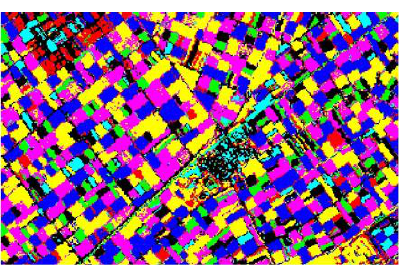
Figure 3. Classified image generated by SVM, where C=10 and